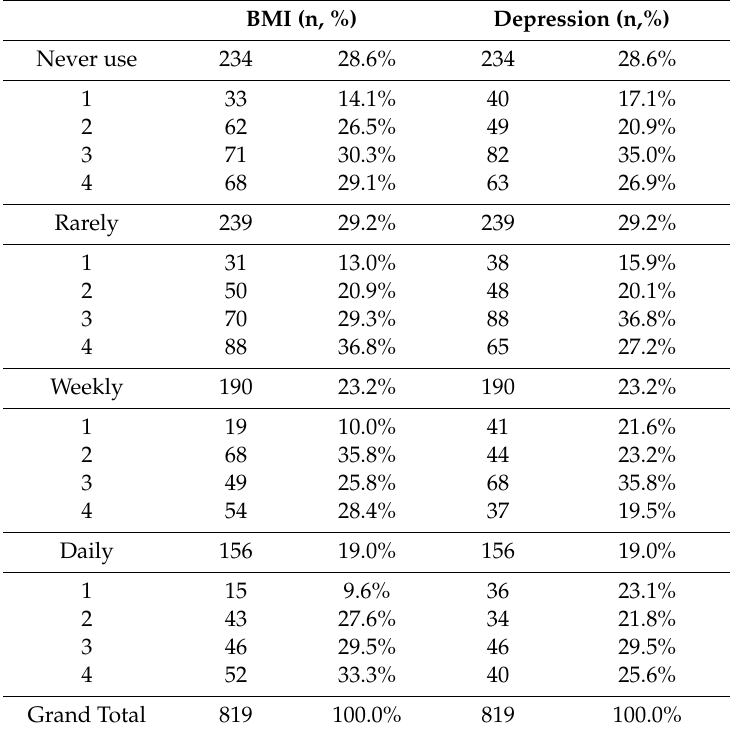
Table 3. Distribution of BMI and depression in di ff erent frequency of using nutrition